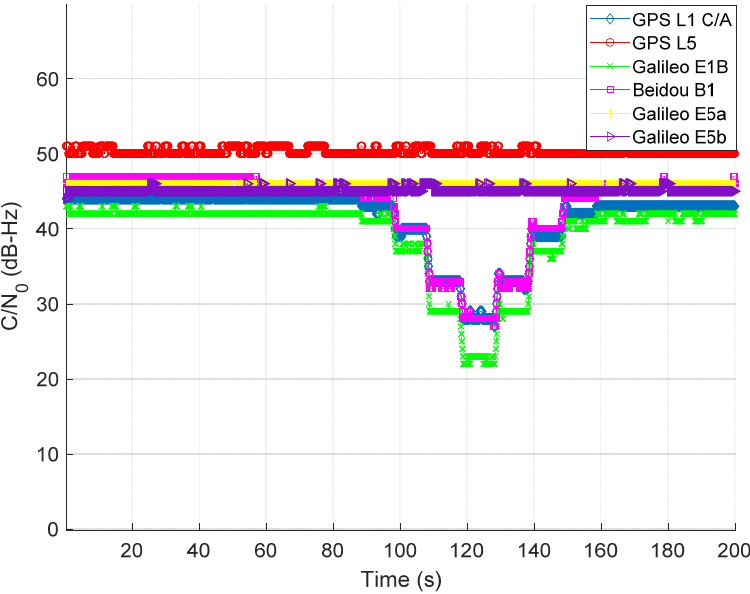
Figure 7. Average C/N 0 of tracked GNSS signals with the presence of jamming on L1/E1/B1 signals.